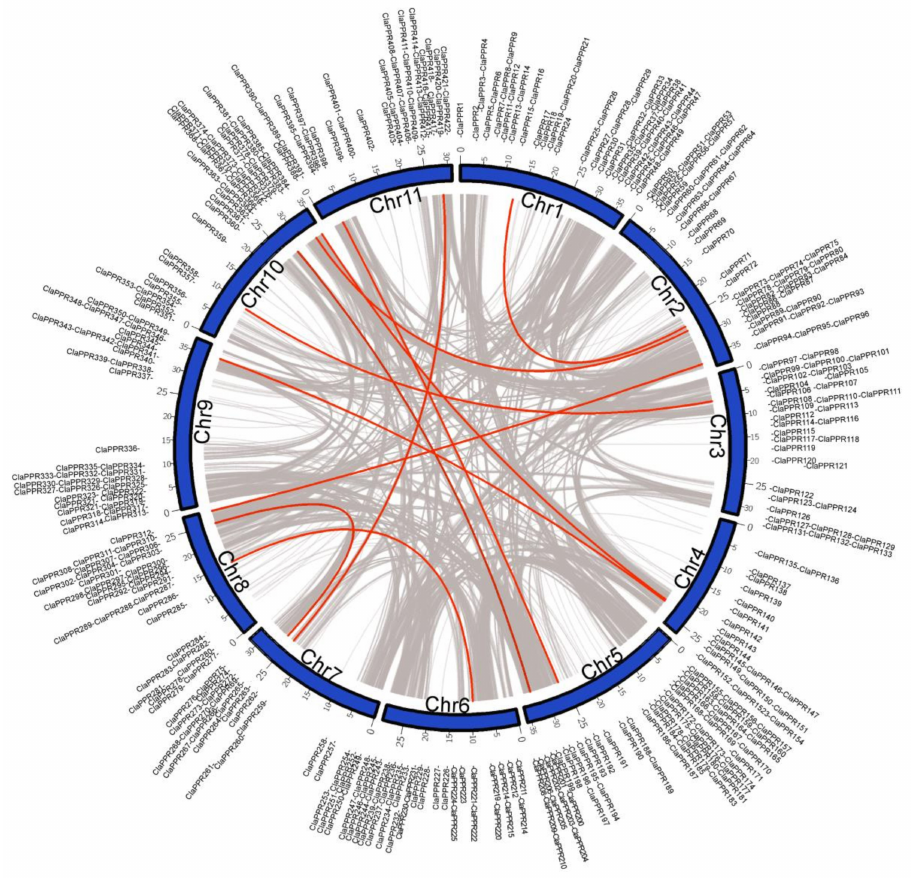
Figure 2. Putative chromosomal localization and gene duplication of ClaPPRs in watermelon. Collinear blocks in whole watermelon genome are indicated by grey lines, while the distributions of segmentally duplicated ClaPPR pairs are connected with red